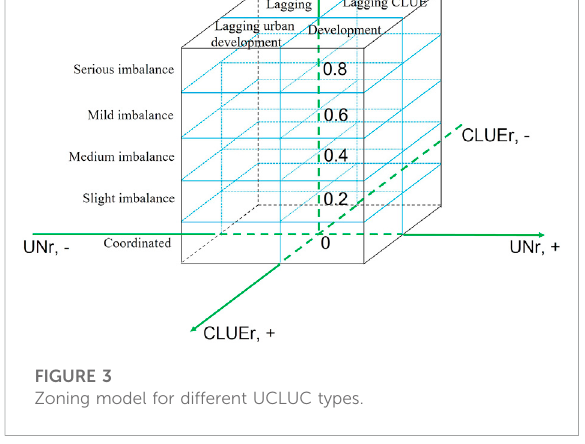
FIGURE 3 Zoning model for different UCLUC